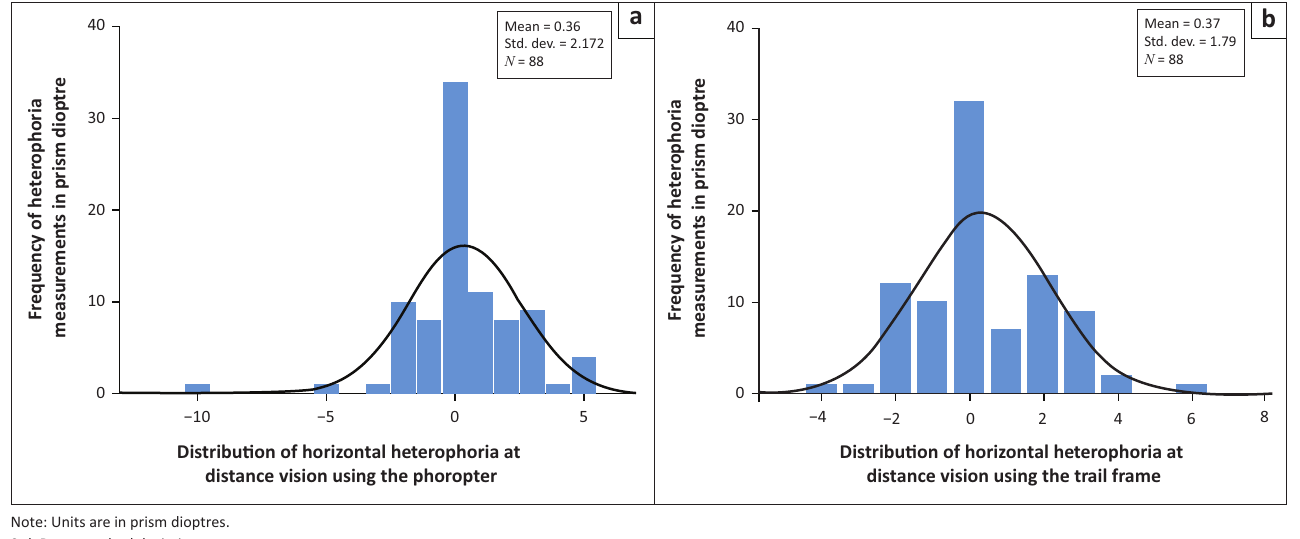
a b Mean = 0.36 Std. dev. = 2.172